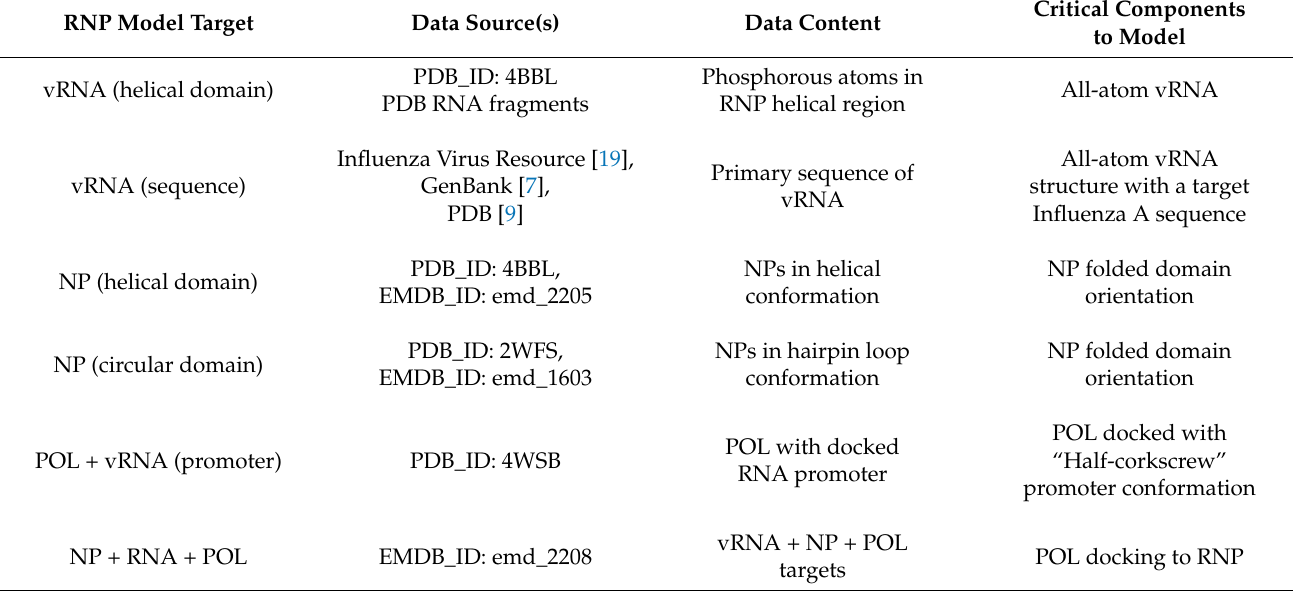
Table 1. Modeling individual components of ribonucleoprotein (RNP). Multiple sequence and structural resources are employed as part of generating the full RNP complex. The individual target components of the RNP model, and the data sources and content needed to produce each target, are provided